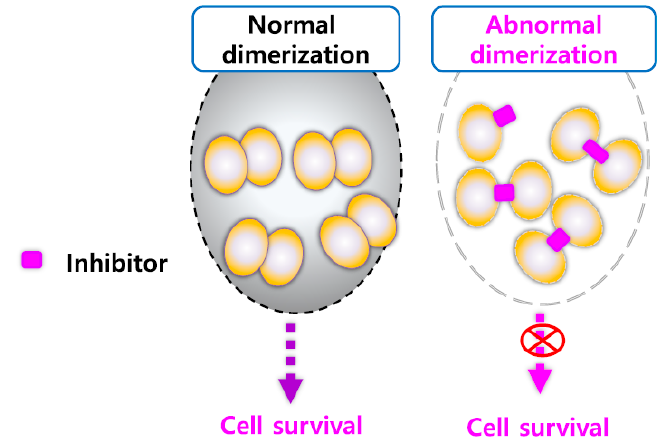
Figure 7. Altered cross-linking of heat shock protein 27 (HSP27) using small molecules for HSP27 inhibition. Scheme for the mechanism of HSP27-cross-linking by small molecules. Normal dimerization of HSP27 contributes to cancer cell survival, but abnormal dimerization of HSP27 using small molecules causes cancer cell death. Table 2. Structure and mechanism of action of small-molecule heat shock protein 27 (HSP27) inhibitors.